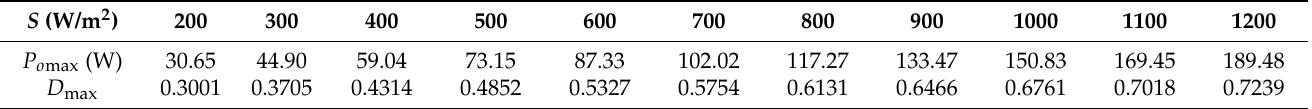
Table 1. MPP values under different irradiance, 20 ◦ C and 1 Ω conditions.